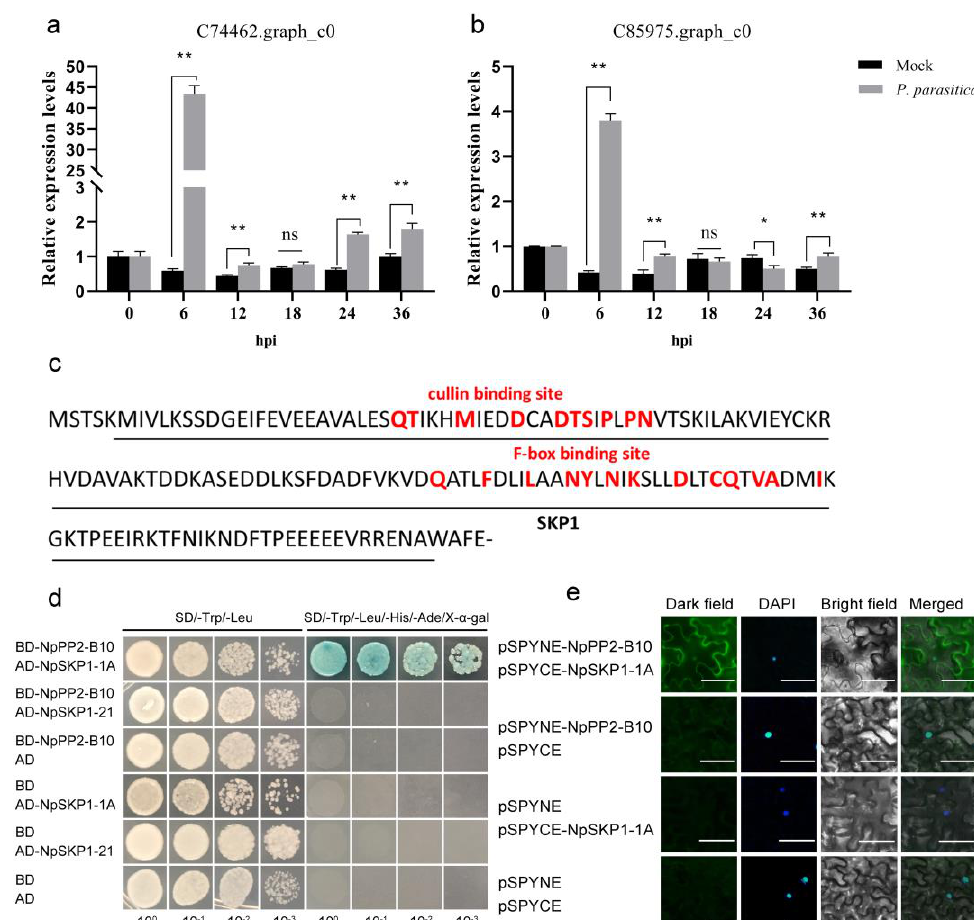
Figure 5. ( a , b ) Relative expression levels of c74462.graph_c0 and 85975.graph_c0 after infection with P. nicotianae race 0. Asterisks denote significant differences (compared with the control group): * p < 0.05, ** p < 0.01, by Student’s t -test; ns, no significant difference. ( c ) Amino acid sequence of